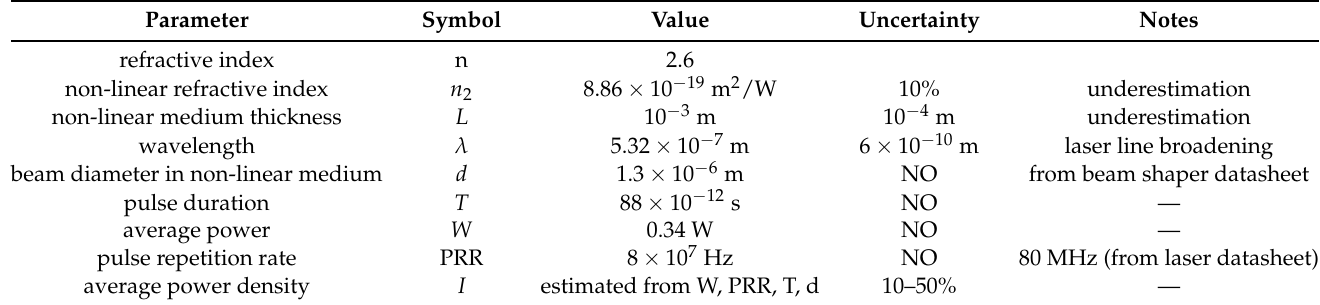
Table 3. Values considered for the parameters and their uncertainties.